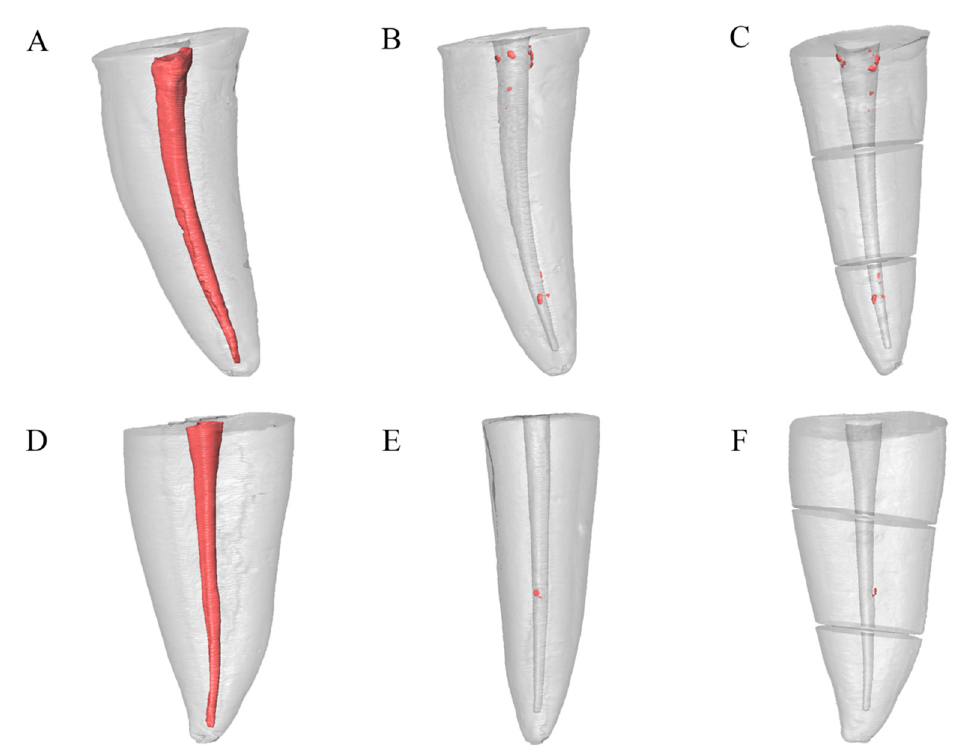
Figure 3. Micro-CT 3D reconstructions of representative samples of both experimental groups. ( A–C ) ProTaper Gold group. ( A ) Preoperative micro-CT image. ( B ) Postoperative micro-CT image. ( C ) Micro-CT image of root thirds. ( D–F ) Reciproc Blue group. ( D ) Preoperative micro-CT image. ( E ) Postoperative micro-CT image. ( F ) Micro-CT image of root thirds.